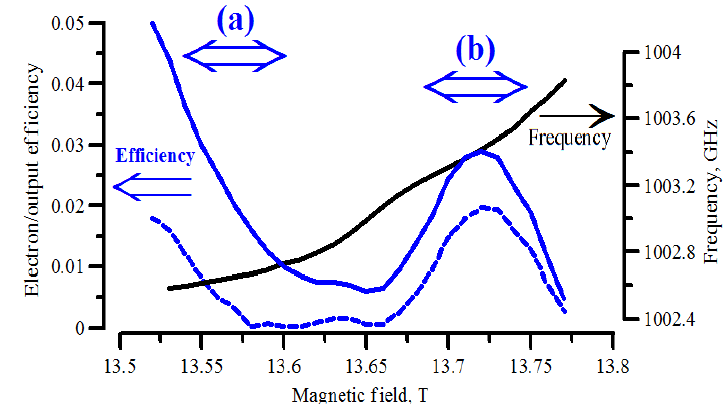
Fig. 1. Dependence of frequency, electron and wave efficiency of a terahertz LOG with a sectioned cavity on the operating magnetic field. Region (a) corresponds to the excitation of the lowest gyrotron mode in the TWT regime, region (b) corresponds to the excitation of the third longitudinal mode in the gyrotron